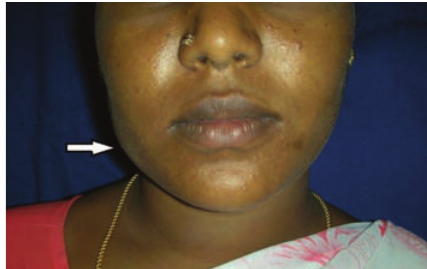
Figure 1: A 23-year-old female patient, presenting with a mild diffuse swelling on the right side of the face.